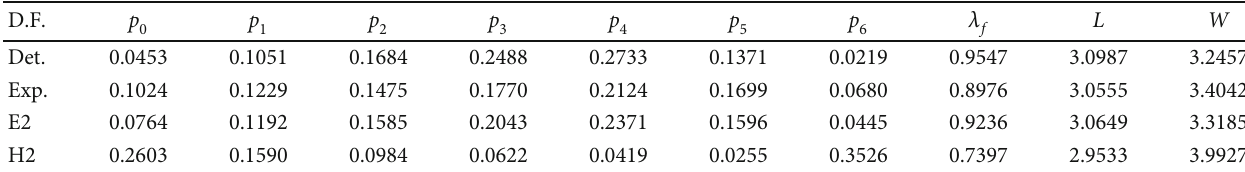
Table 1: The model with M = 6 , N = 3 , Y = 3 , and ρ = 0 : 4 :